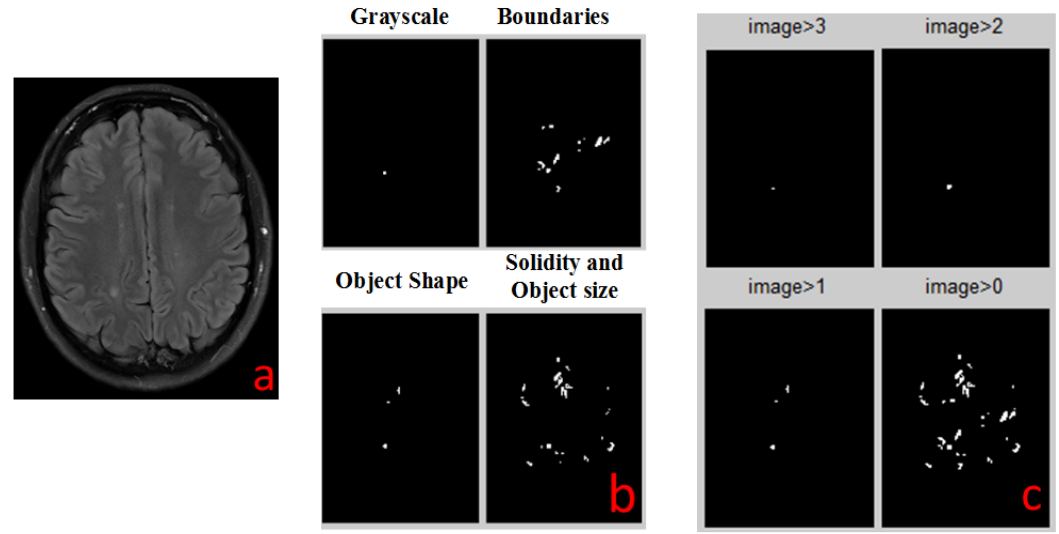
Figure 5. MS detection for image with T2_TIRM type: ( a ) original Image; ( b ) results of all detection algorithms; ( c ) combination of all detection results, displaying pixels with value greater than a threshold value (see titles). The value of each pixel denotes the number of algorithms (out of 4) that detected this pixel as part of a positive suspected MS lesion.